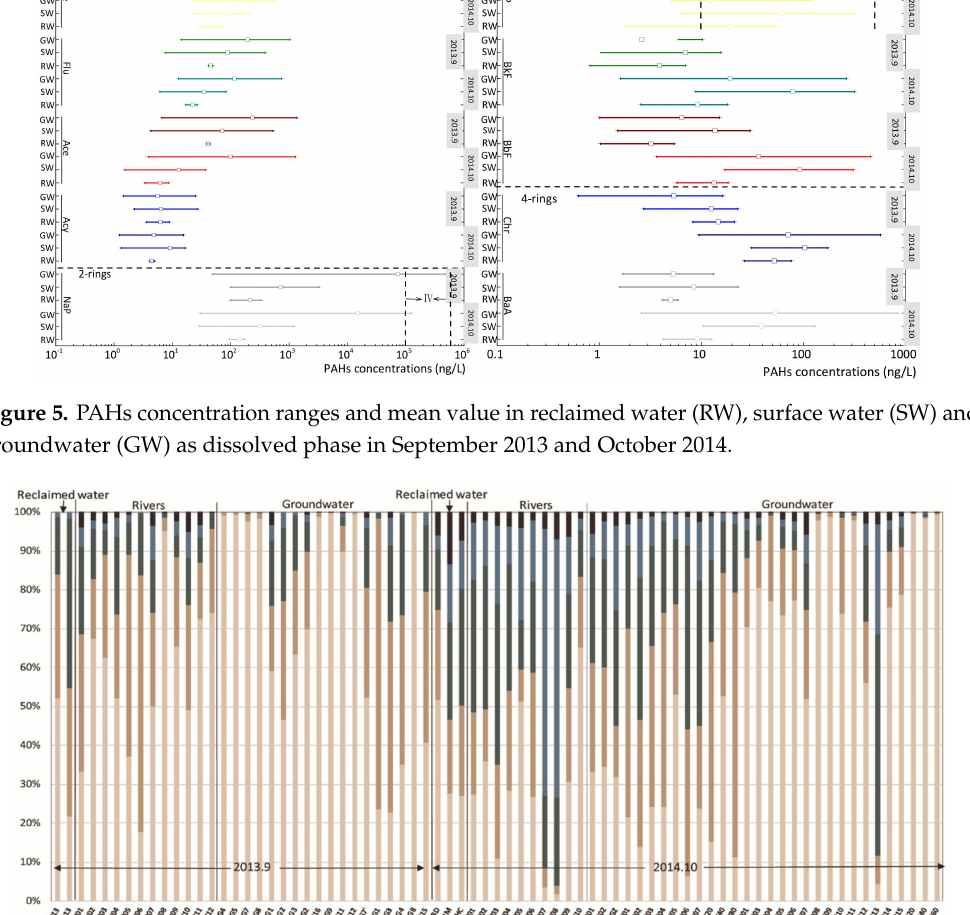
Figure 6. Composition pattern of September 2013 and October